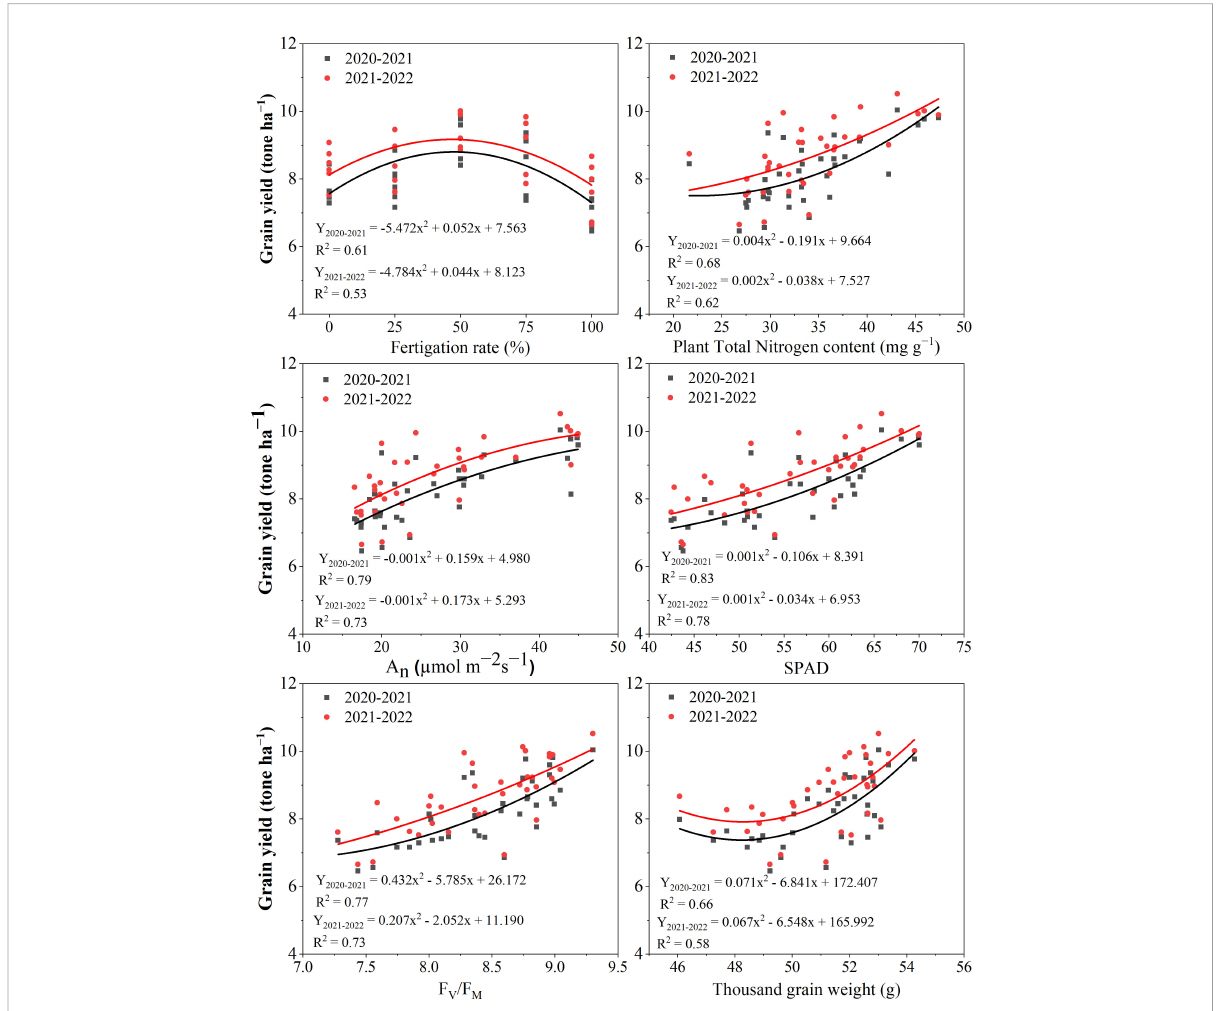
FIGURE 7 Winter wheat grain yield response to various parameters during the 2020-2021 and 2021-2022 growing